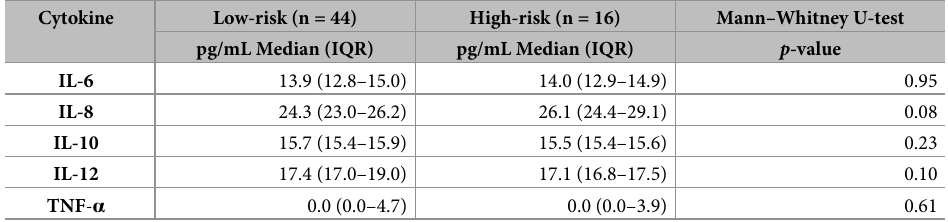
Fig 1. CD4+ and CD8+ T cells basal activation profile in both MSM groups. Comparison of the percentage of (A) CD4+ and (B) CD8+ T cells expressing HLA-DR, Ki-67, CD38, and CD69 activation markers between the groups. High-risk group (n = 16), low-risk group (n = 44). All data are reported after background correction. The comparison was performed with the Mann–Whitney U-test or Student T-test according to the data distribution. https://doi.org/10.1371/journal.pone.0277120.g001 Table 2. Plasma levels of cytokines in both groups of